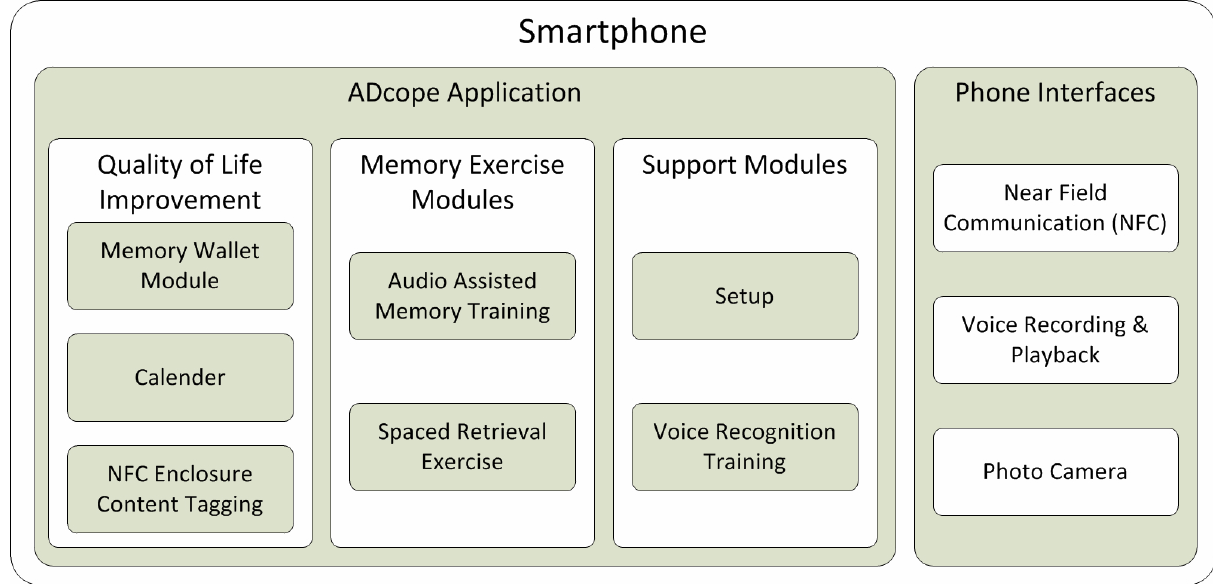
Figure 1. ADcope modules and